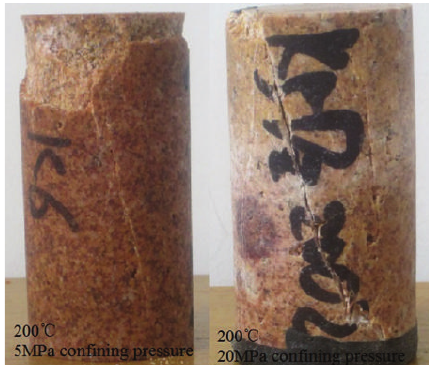
Figure 15: Permeability curve under different temperatures in